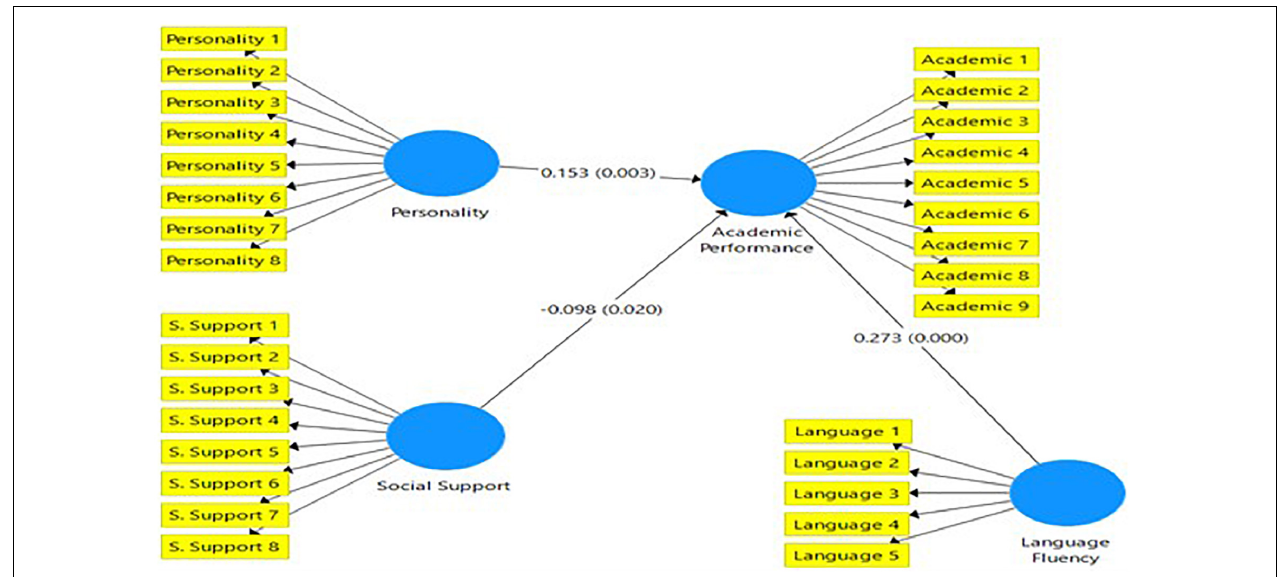
FIGURE 3 | Structural model.